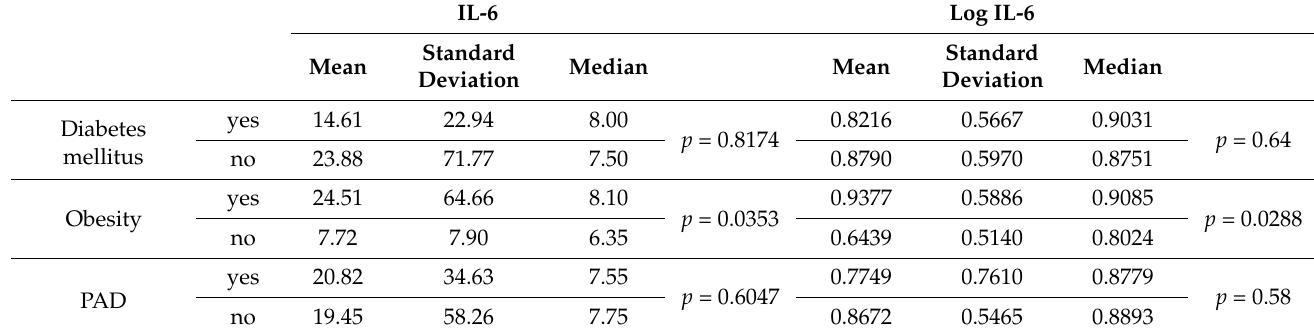
Table 6. The correlation between the serum levels of IL-6/Log IL-6 and the presence of associated comorbidities in the patients included in the study.